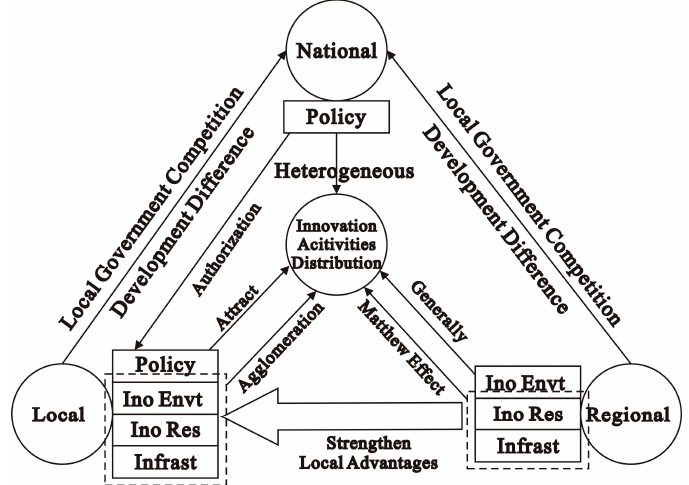
Figure 2. The multilevel mechanism of innovation activities distribution in China’s NEV industry.